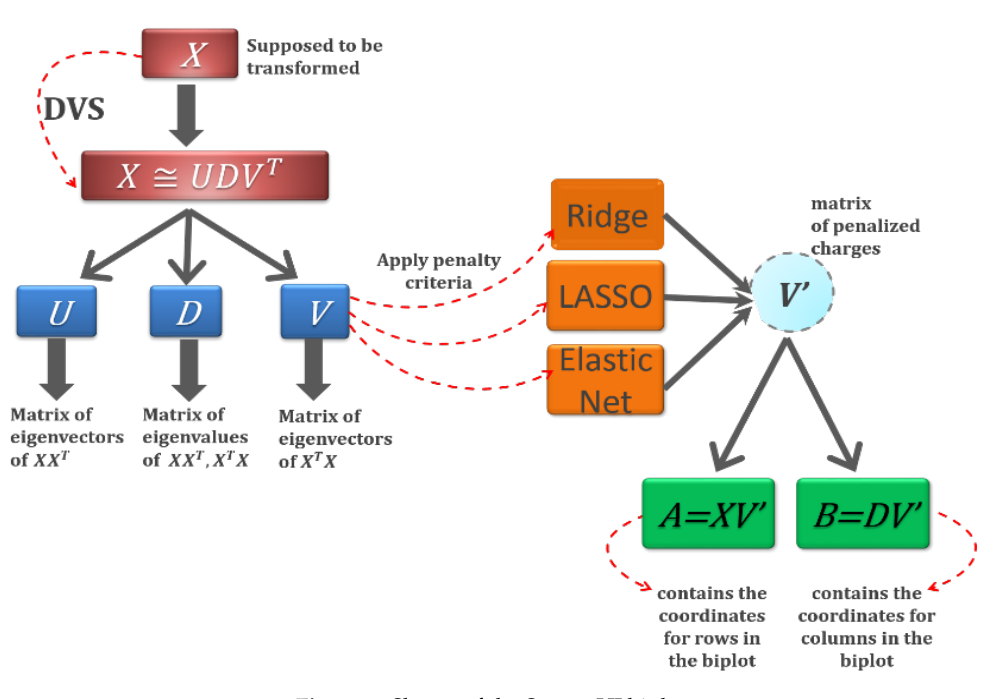
Figure 2. Sheme of the Sparse HJ biplot. Explained variance by the Sparse HJ biplot.